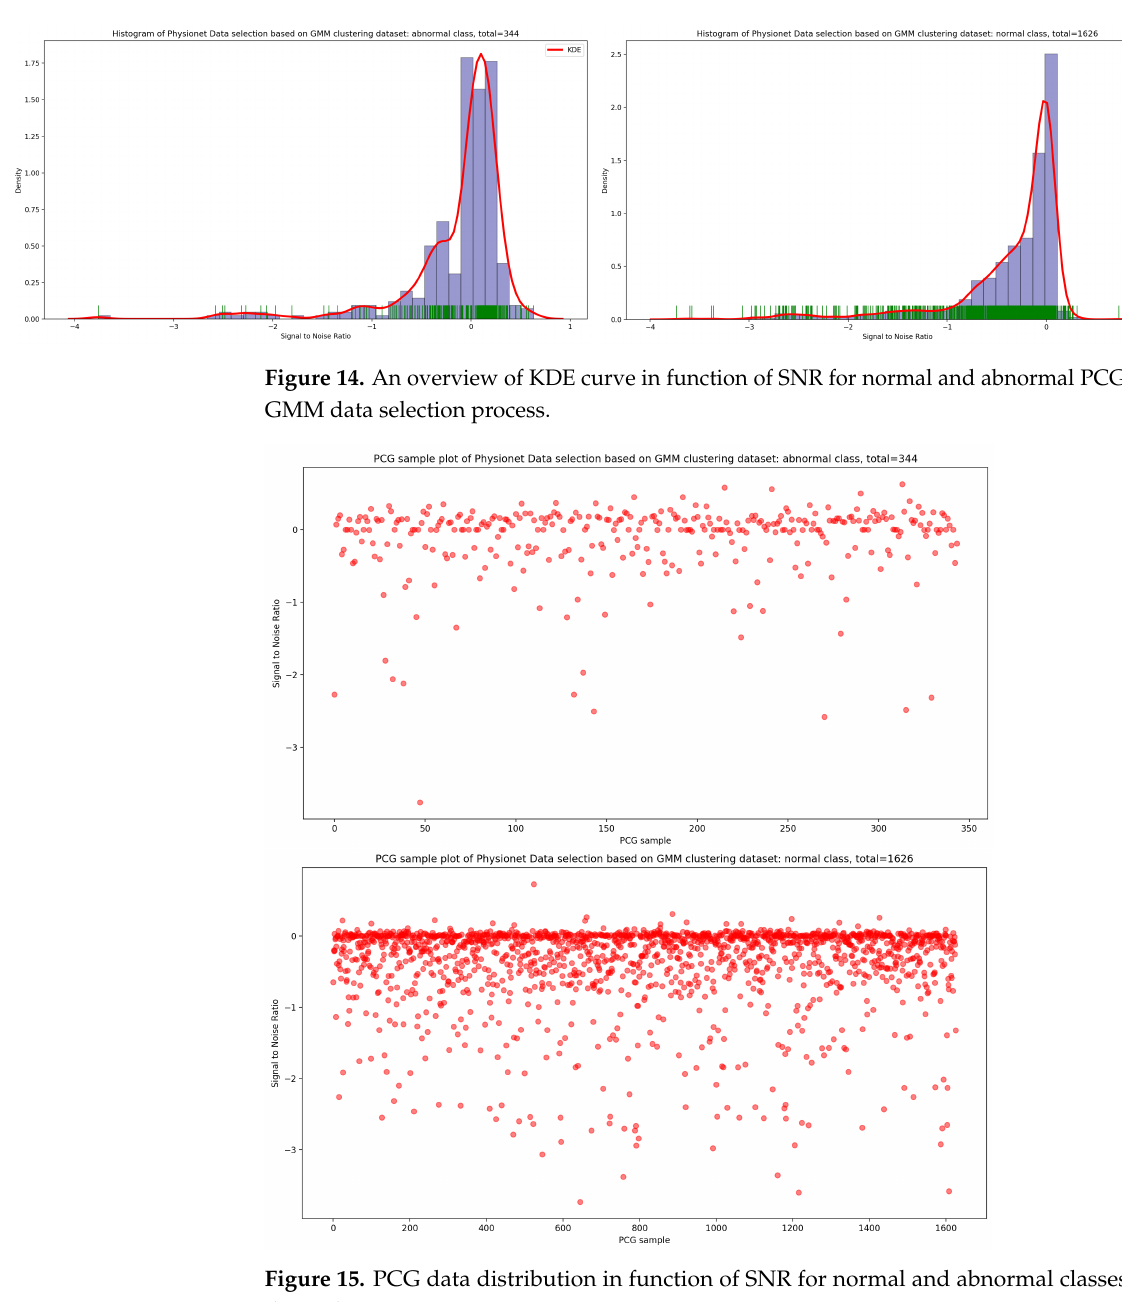
Figure 15. PCG data distribution in function of SNR for normal and abnormal classes after GMM data selection